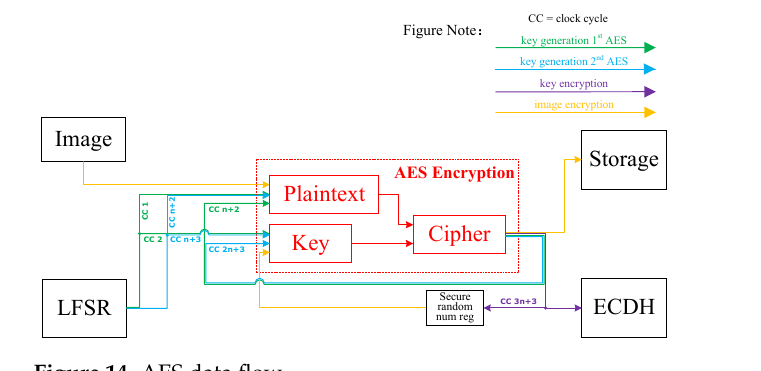
Figure 14. AES data